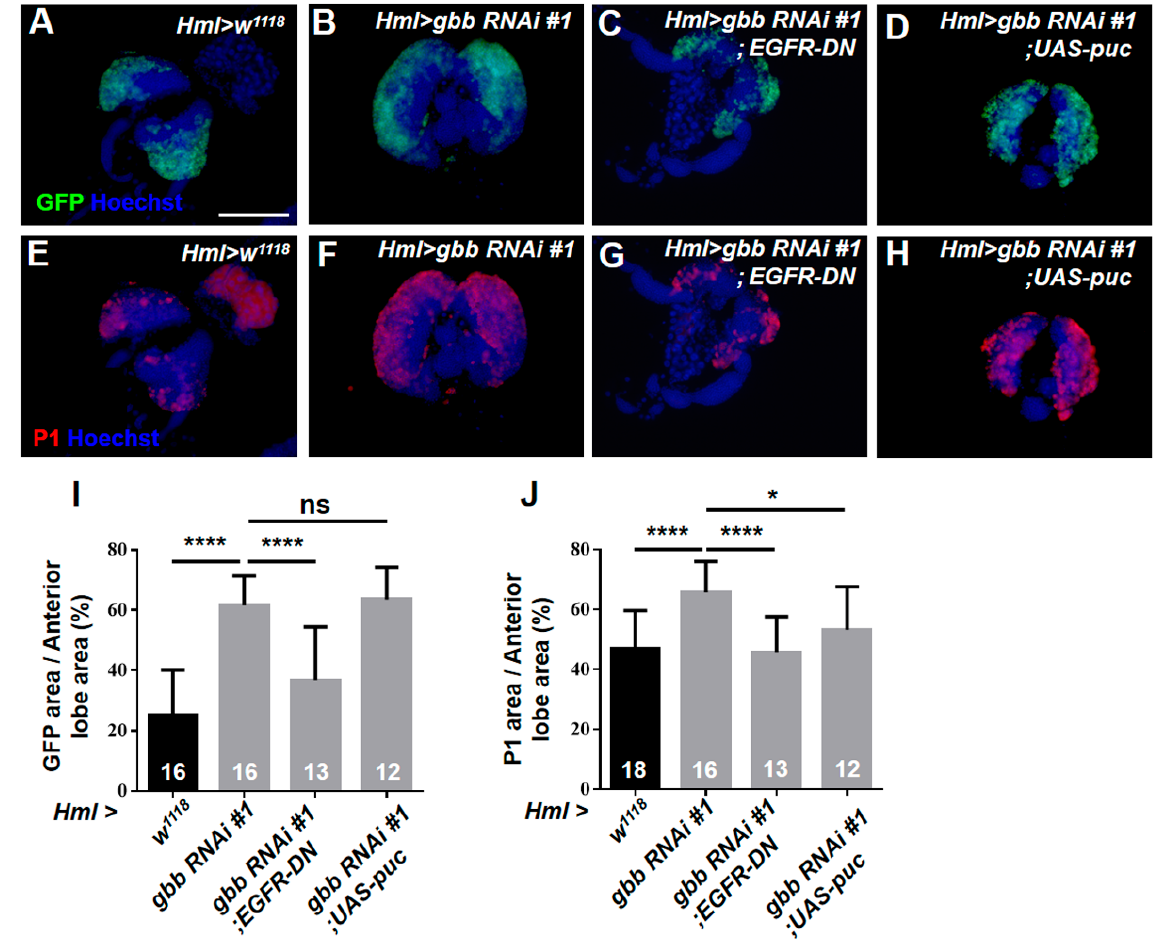
Figure 3. The knockdown of Gbb in the CZ induces plasmatocyte differentiation by activating the EGFR pathway but not the JNK pathway. ( A – D ) The Hml-GFP-positive area represents the area of the CZ. ( E – H ) Immunostaining for the plasmatocyte marker P1 showed that the P1-positive area was increased in the Hml > gbb RNAi#1 lymph gland ( F ), and the aberrant plasmatocyte differentiation was rescued in Hml > gbb RNAi #1 > EGFR-DN ( G ) and Hml > gbb RNAi #1 > UAS-puc lymph glands ( H ). ( I , J ) Quantification of the proportions of the anterior lobes occupied by the Hml-GFP + area ( I ) and P1+ area ( J ), respectively. For all quantifications: ns, not significant; * p < 0.05; **** p < 0.0001 (Student’s t test). Scale bars: 100 μ m ( A – H ).